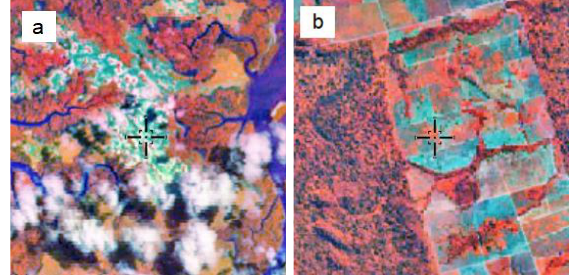
Figure 9a. other non-forest natural formation and presence of clouds; Figure 9b. Cultivated